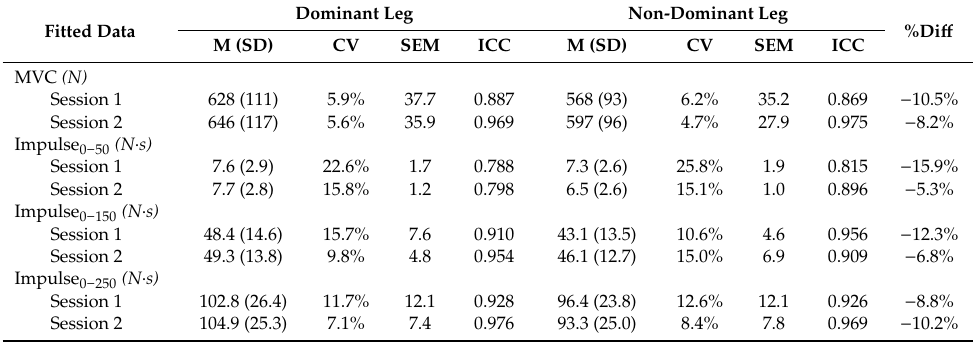
Table 2. Intra-session reliability in maximal voluntary contraction force (MVC), rate of force development (RFD) and impulse variables for filtered data